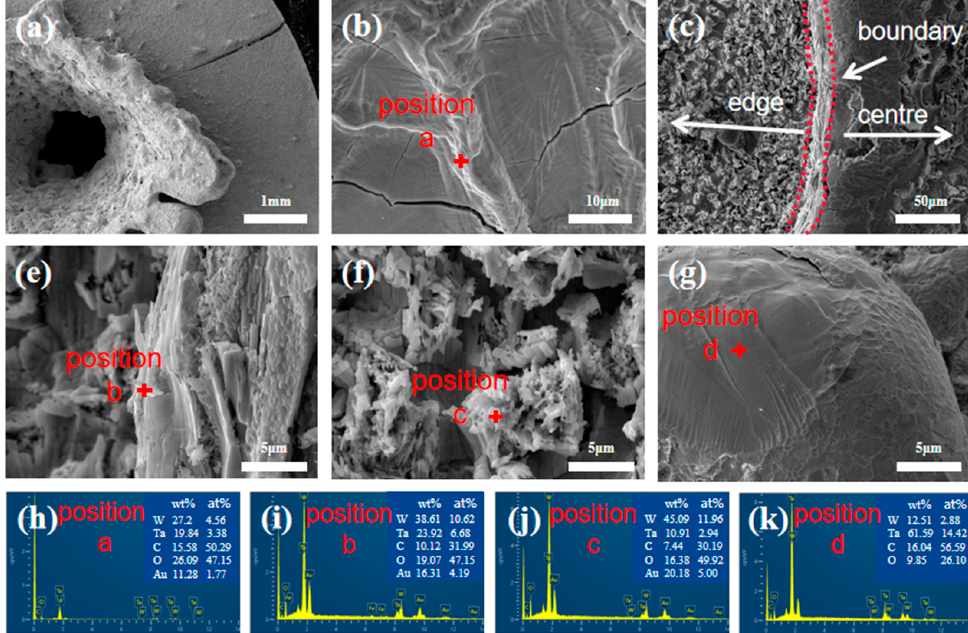
Figure 6. Microstructure and EDS results at corresponding locations in the WTA3 composite after air plasma ablation.